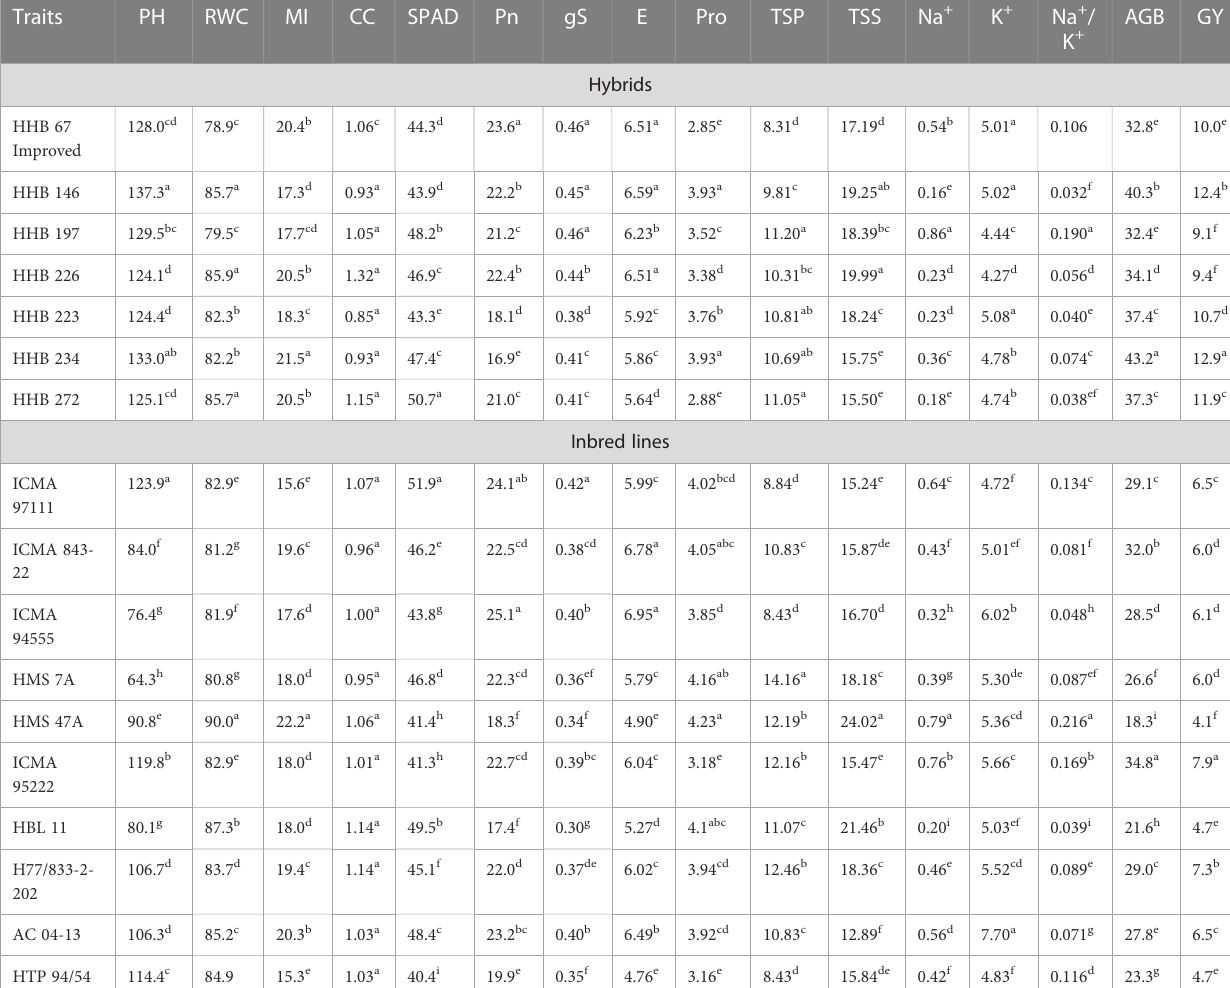
TABLE 4 Mean response of evaluated hybrids and inbred lines for plant water relations, gas exchange, osmolyte accumulation, ionic balance and yield parametes in pearl millet (averaged across salinity levels). Traits PH RWC MI CC SPAD